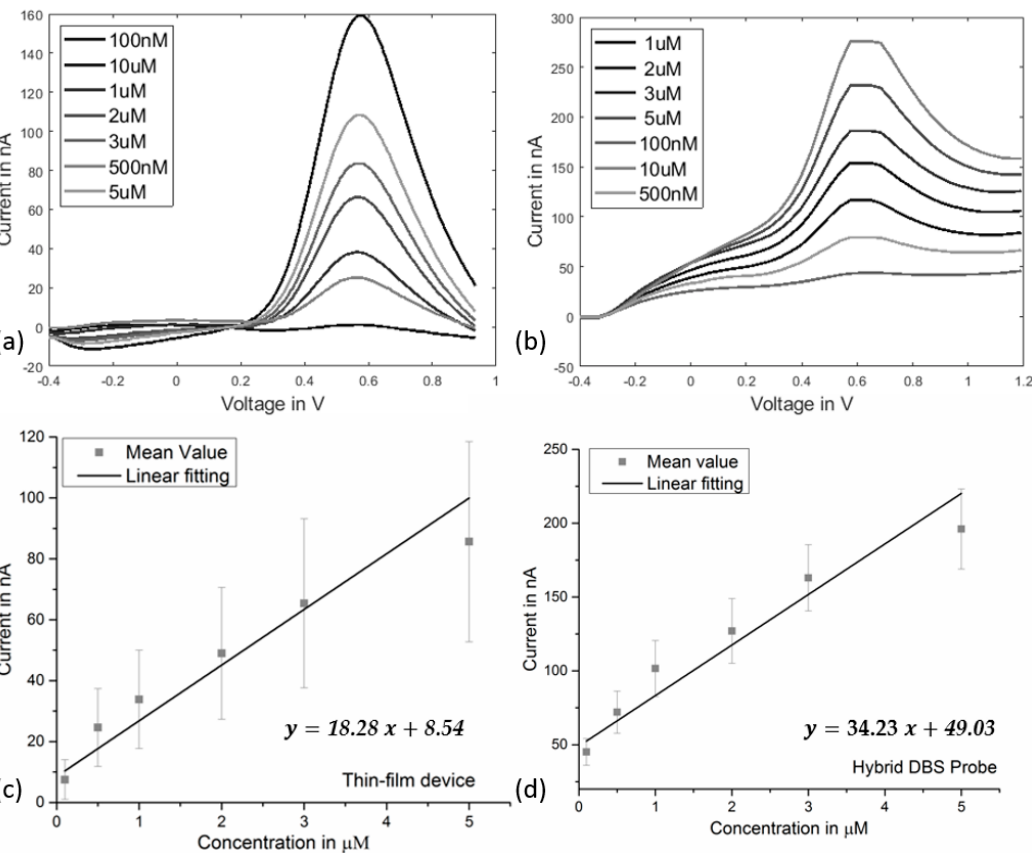
Figure 6. In vitro calibration curves of the conducted FSCV experiments for the thin-film devices as well as the hybrid probes; ( a ) representative FSCV diagram using thin-film device; ( b ) representative FSCV diagram of one of the calibrated hybrid probes with the calculated standard deviations; ( c ) linear fitting of the calibration curve for the thin-film device (n = 3); ( d ) linear fitting of the calibration values based on the calculated average for the hybrid assembly (with the calculated standard deviations ; n = 6).